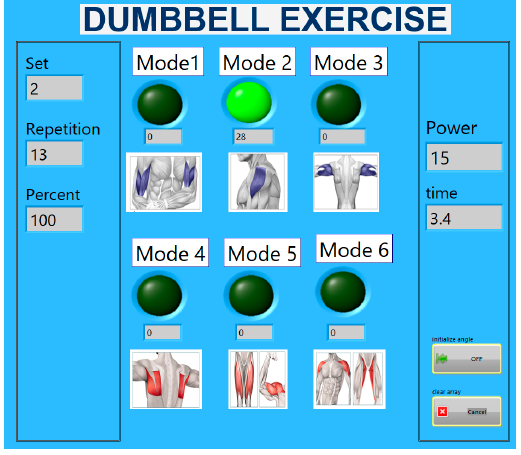
Figure 9. The decision surface for four different SVM classifiers of mode dumbbell exercises (red = Bicep, orange = Deltoid, lack = Tricep, green = Shoulder, blue = Squat, purple = Side and lunge).